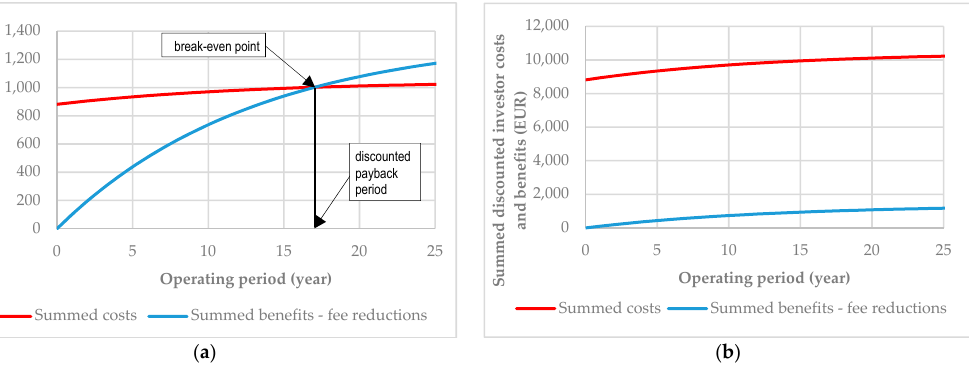
Figure 2. Summed discounted investor costs and benefits for estate 1: ( a ) for minimalistic investment—bioswale with a capacity of 0.1% of the annual outflow; ( b ) for investment—bioswale with a capacity of 1% of the annual outflow.